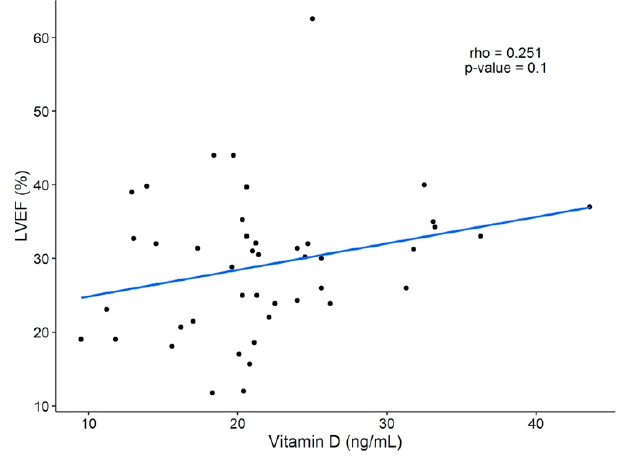
Figure A2. Linear correlation between LVEF (%) and 25(OH)D concentration. A weak positive correlation was found ( R = 0.251), but no statistical significance was seen. LVEF = left ventricular ejection fraction; 25(OH)D = 25-hydroxivitamin D.